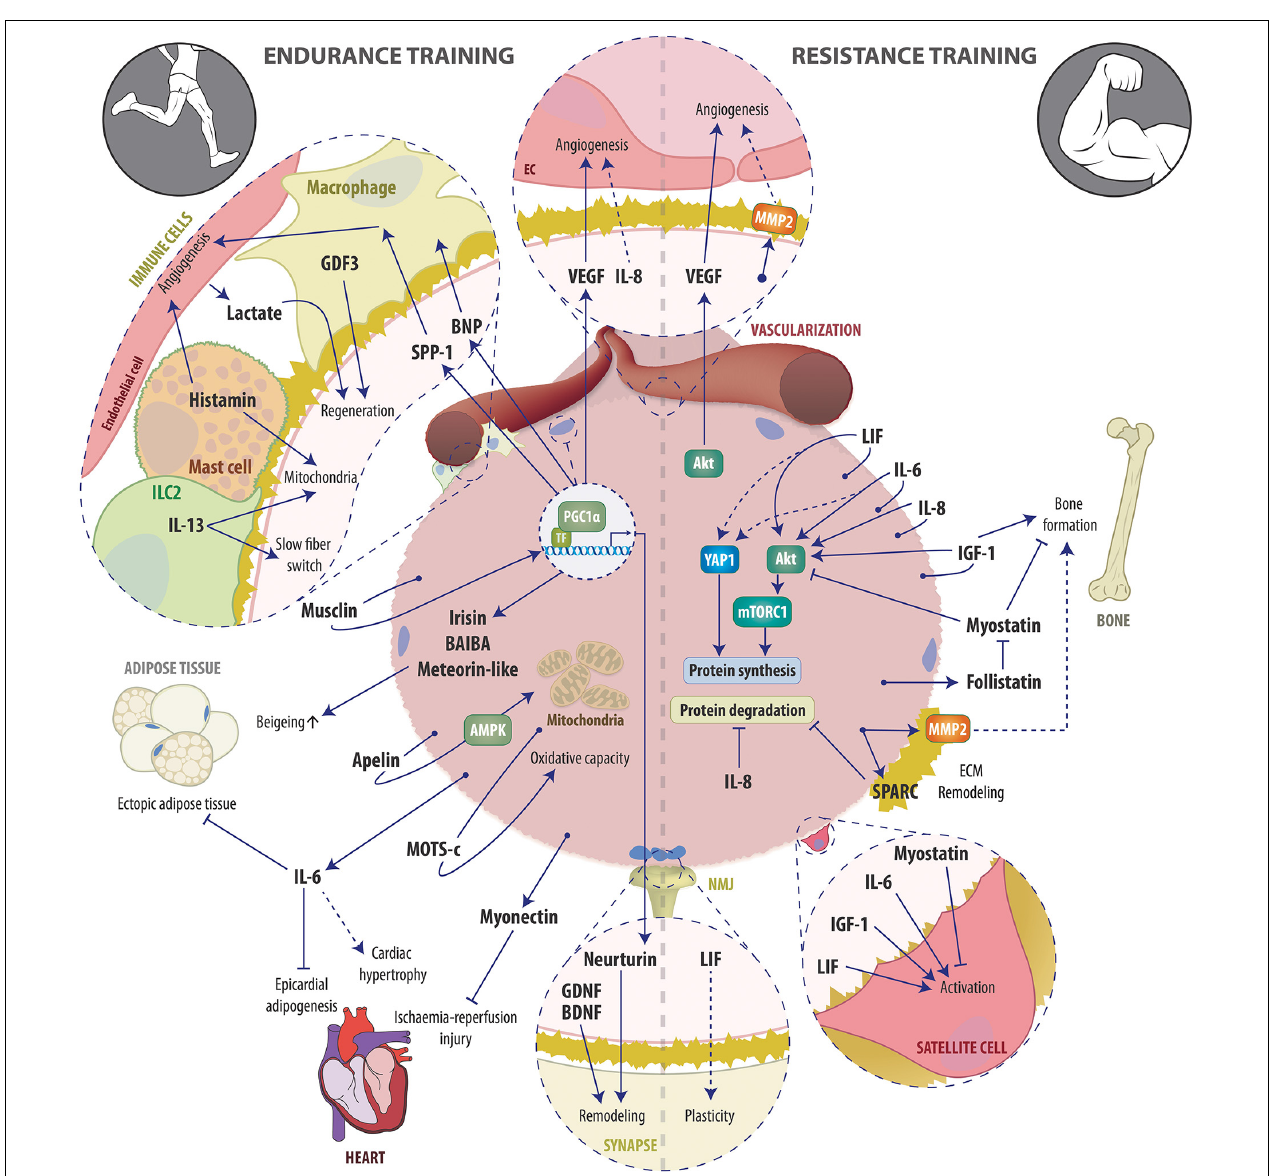
FIGURE 1 | Schematic overview of examples of the endurance (left) and resistance (right) exercise-induced muscle secretome and its auto-, para-, and endocrine actions involved in training adaptation. See text for details. Abbreviations: AMPK, AMP-dependent protein kinase; Apelin, APJ Endogenous Ligand; BAIBA, β -aminoisobutyric acid; BDNF, Brain-derived neurotrophic factor; BNP, B-type or brain natriuretic peptide; EC, endothelial cell; ECM, Extracellular matrix; GDF3, macrophage-derived growth differentiation factor 3; GDNF, glial cell line-derived neurotrophic factor, IGF-1, Insulin-like growth factor-1; ILC2, innate lymphoid cells type 2; IL-6, Interleukin-6; IL-8, Interleukin-8; IL-13, Interleukin-13; LIF, Leukemia inhibitory factor; MOTS-c, mitochondrial ORF of the 12S ribosomal RNA type-c; MMP2, Matrix metalloproteinase-2; mTORC1, mammalian target of rapamycin complex 1; NMJ, Neuromuscular junction; PGC-1 α , peroxisome proliferator-activated receptor γ coactivator 1 α ; SPARC, Secreted protein acidic and rich in cysteine; SPP-1, secreted phosphoprotein 1; TF, transcription factor; VEGF, Vascular endothelial growth factor; YAP1, Yes-associated protein